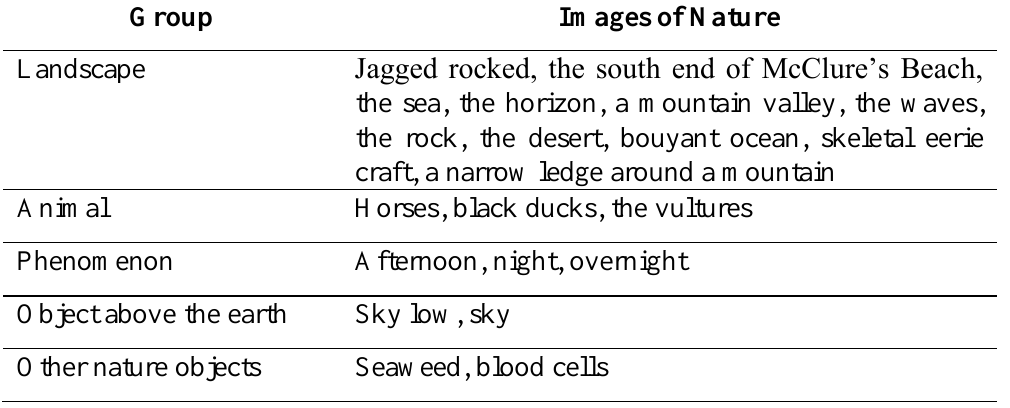
Table 2. Images of Nature Group